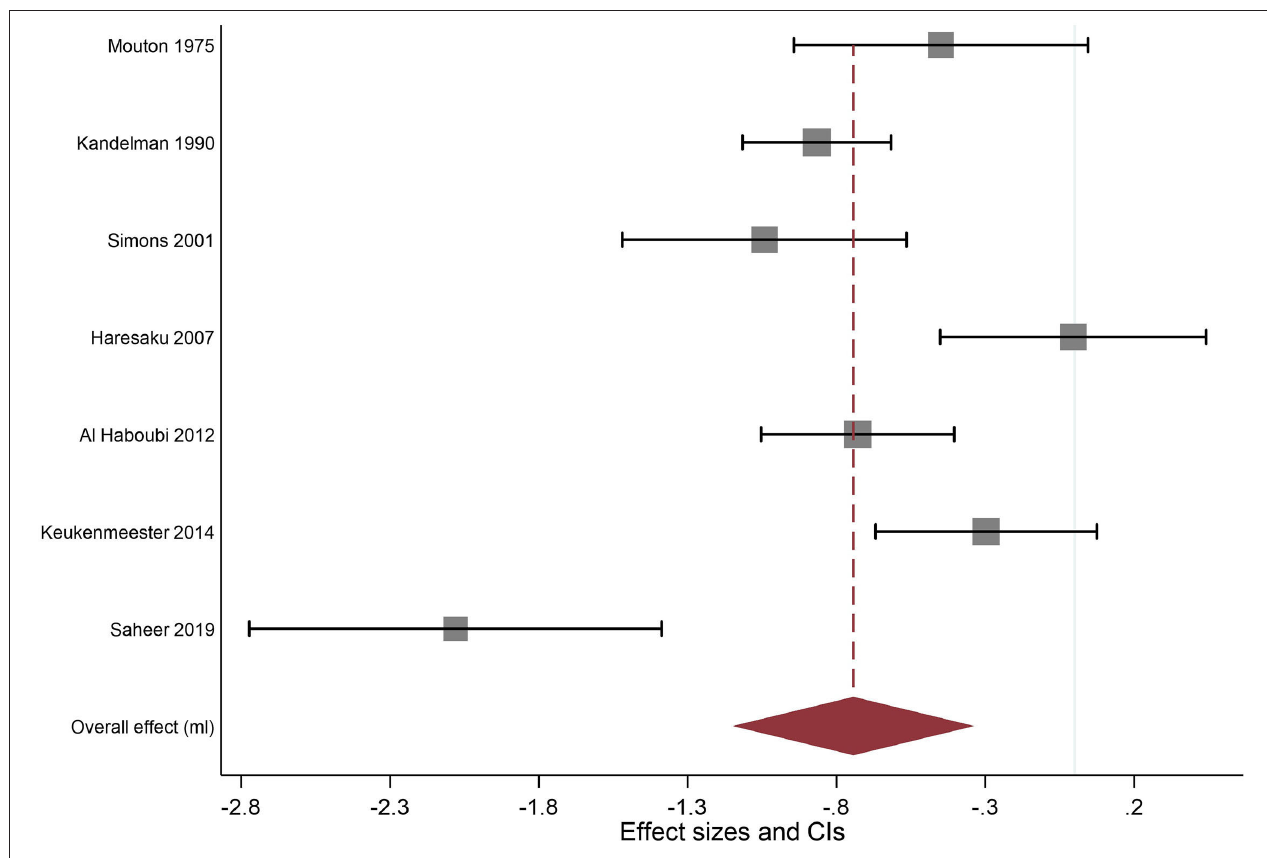
FIGURE 4 | Original weights (squares) displayed. Largest to smallest ratio: 1:41.